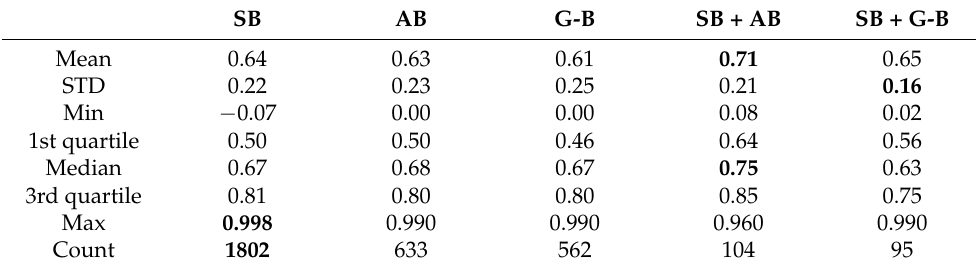
Table 8. Statistical analysis of R 2 in various